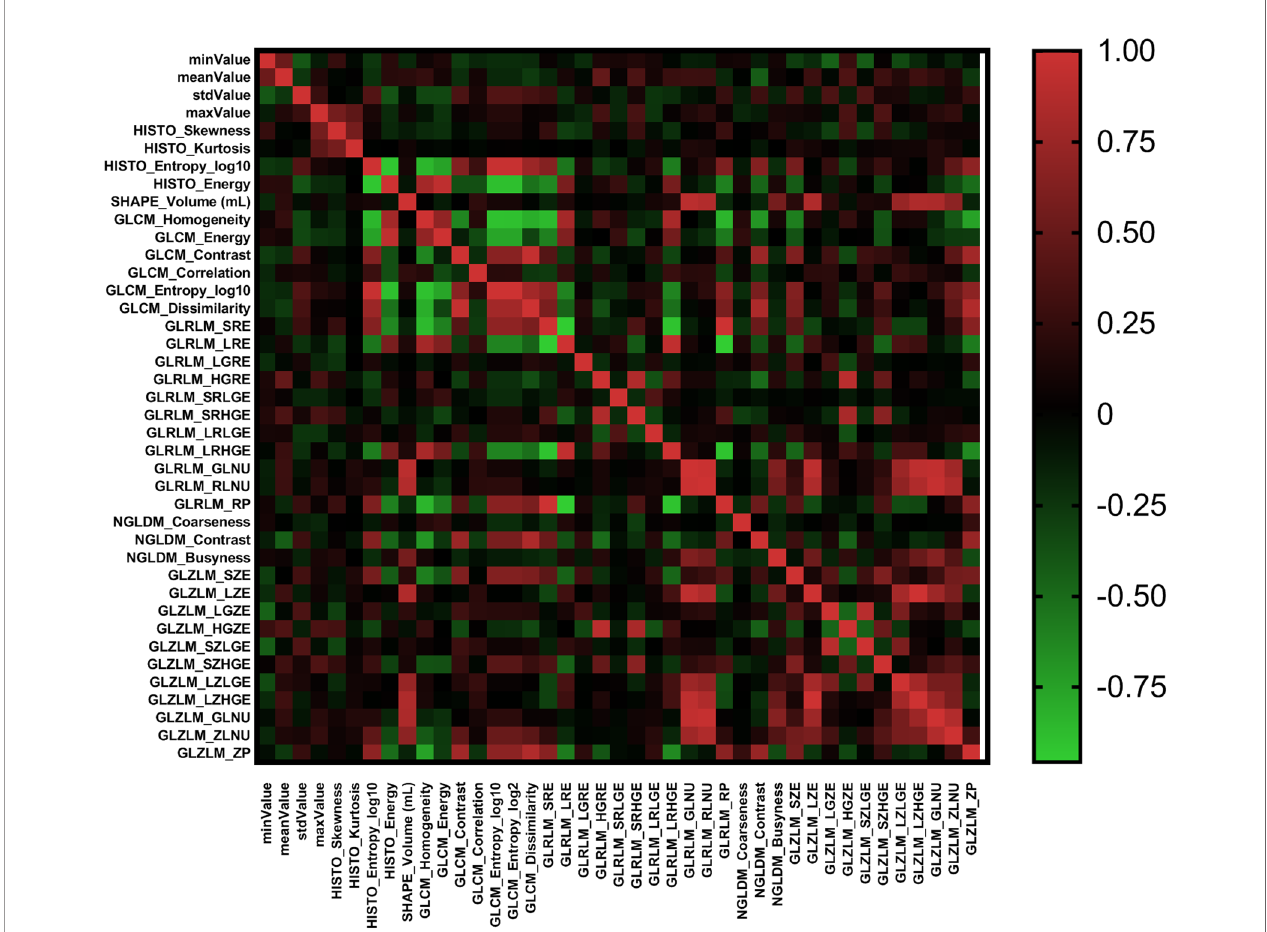
FIGURE 2 | The heat map of Pearson correlation coef fi cients among radiomics